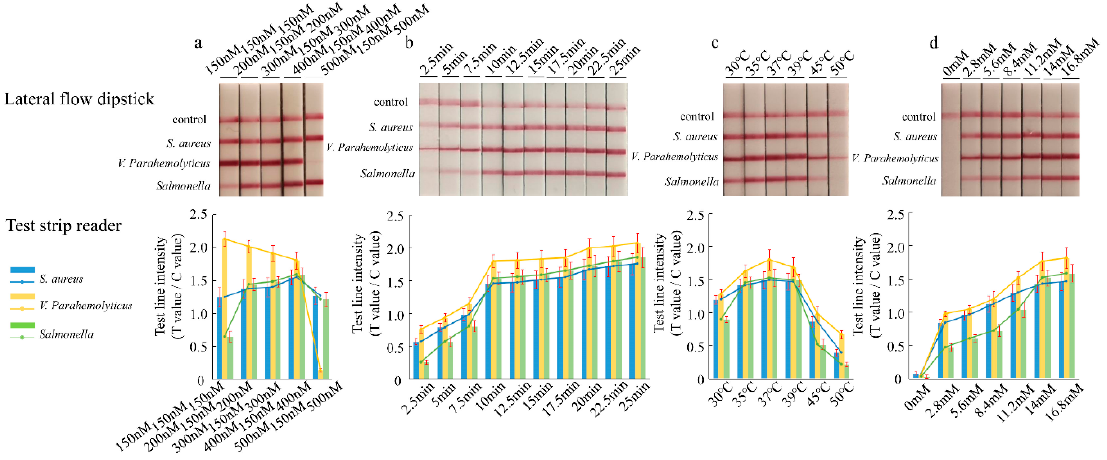
Figure 2. Optimization of the recombinase polymerase amplification reaction. Ratios of primers ( a ), incubation time ( b ), temperature ( c ), and the concentration of magnesium ions ( d ) using target DNA. LFD test results (top) and LFD test line quantification (bottom). The test line intensity was the ratio of the reflected light for the test line and control line.